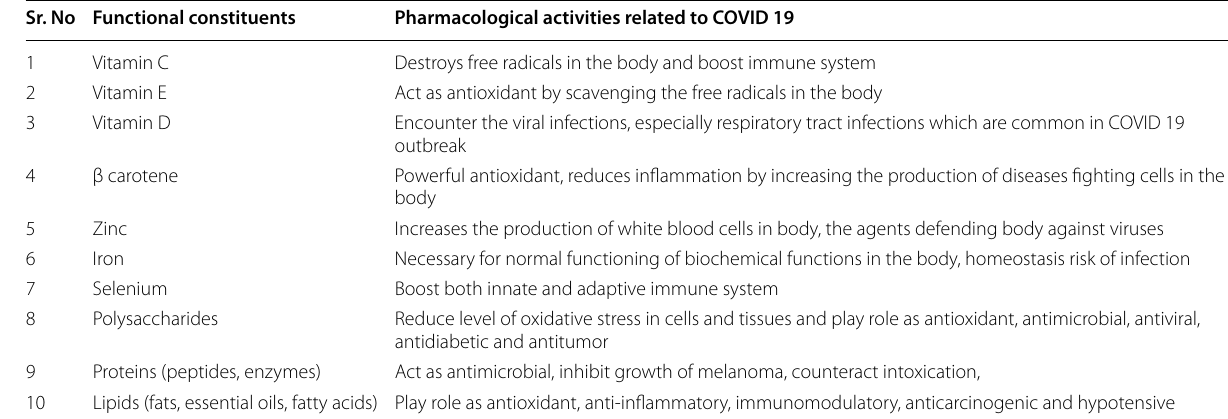
Table 1 Functional constituents present in pumpkin and their pharmacological activities related to COVID 19 pandemic Sr. No Functional